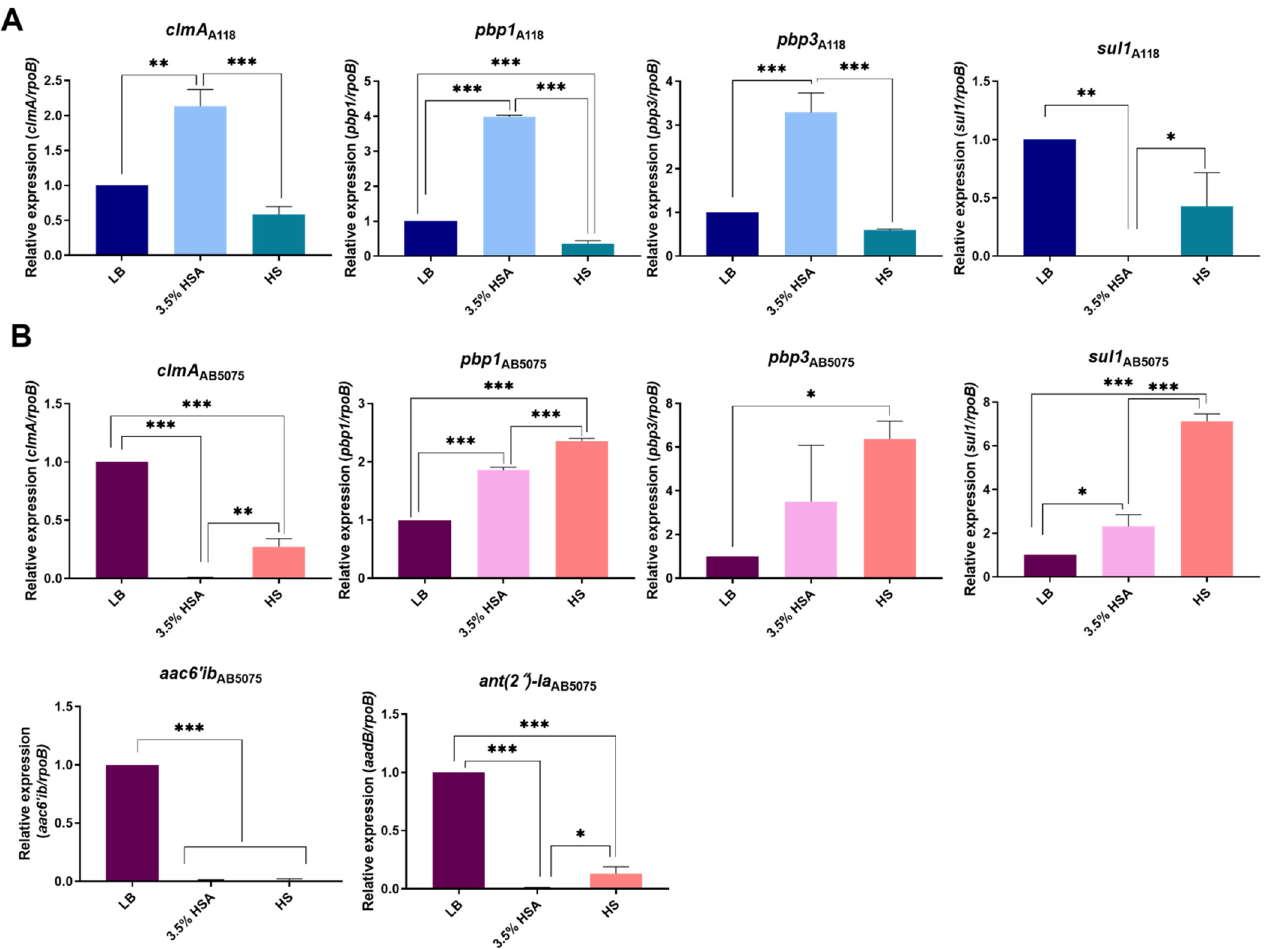
Figure 1. Effect of human serum albumin (HSA) and pooled normal human serum (HS) on the expression of antibiotic resistance genes of A. baumannii A118 and AB5075 strains. qRT-PCR of A118 ( A ) and AB5075 ( B ) strains genes associated with antibiotic resistance expressed in LB, LB supplemented with 3.5% HSA, or in HS. Fold changes were calculated using double ∆∆ Ct analysis. At least three independent samples were used. LB was used as the reference condition. Statistical significance ( p < 0.05) was determined by ANOVA followed by Tukey’s multiple-comparison test, one asterisks: * p < 0.05; two asterisks: ** p < 0.01, and three asterisks: *** p <